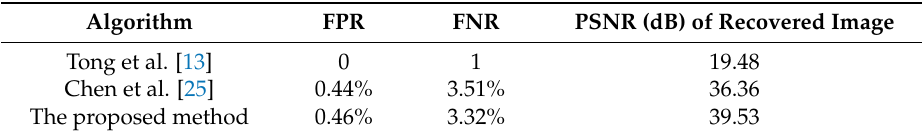
Table 7. Performance comparisons for content-only attack using Clock image.